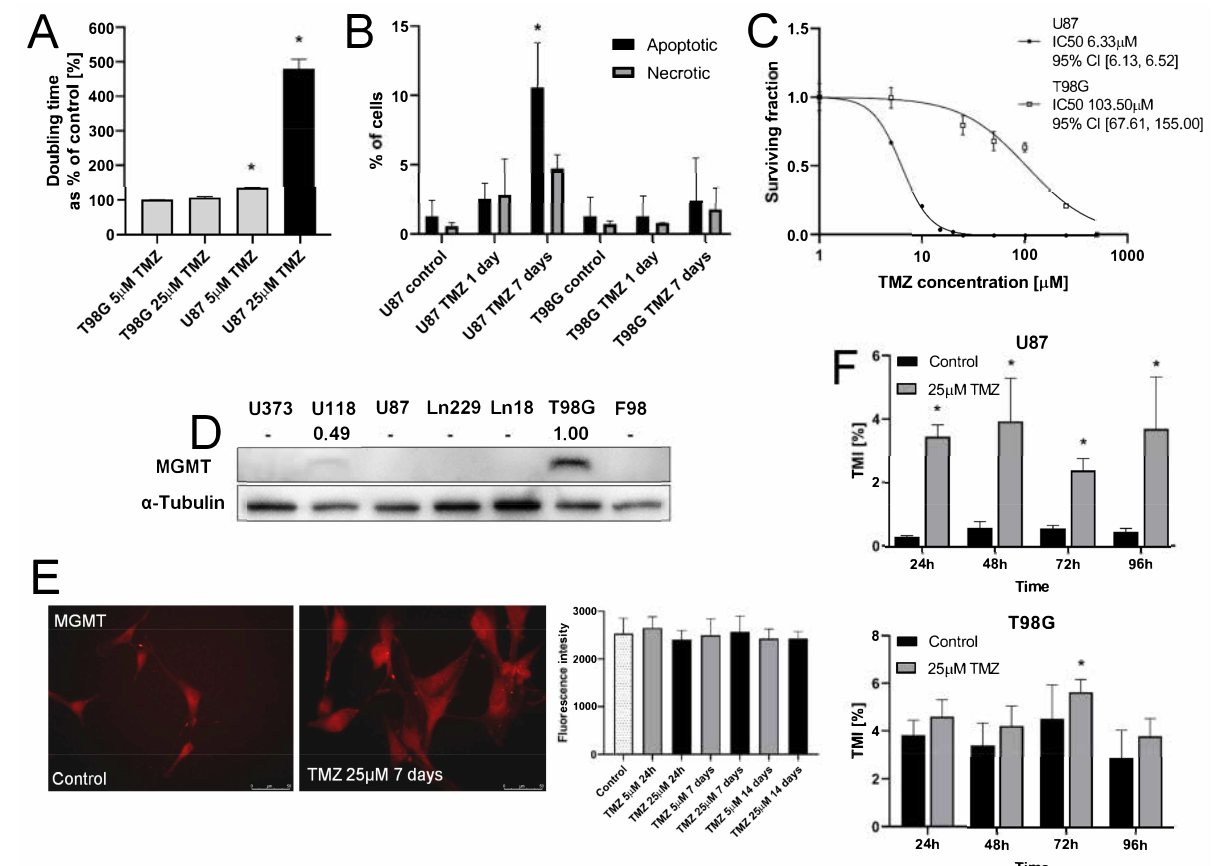
Figure 1. Sensitivity of T98G and U87 cells to temozolomide (TMZ). ( A ) U87 and T98G cells were incubated in the presence of 5 or 25 µ M TMZ. Their proliferation was estimated after the next 24–96 h with Coulter Counter to calculate the population doubling times (for growth curves cf. Figure S1A). ( B ) Cells were treated with 25 µ M TMZ and their apoptotic response was estimated after 24 h and seven days with AnnexinV/PI assay. At least 5000 single cells were analyzed, gated according to their area/aspect ratio (for original dot-plots, see Figure S1B). ( C ) Dose-dependence of cell survival under TMZ stress estimated with clonogenic assay. ( D ) O6-Methylguanine-DNA Methyltransferase (MGMT) levels in T98G and U87 cells cultivated in control conditions were estimated with immunoblotting. Numerical data show the density of MGMT-specific bands intensity calculated against the levels of α -tubulin as the housekeeping gene. ( E ) Cytofluorimetric analyses of TMZ effect on MGMT levels in U87 cells undergone 25 µ M TMZ treatment (see also Figure S1C). Scale bar 50 µ m ( F ) The effect of TMZ on the efficiency of T98G/U87 transmigration through microporous membranes (Transwell assay). Statistical significance was calculated with ANOVA/non-parametric Mann–Whitney test, * p < 0.05 vs. control. Data representative for three independent experiments. Note the correlation between MGMT levels and TMZ-resistance of U87 and T98G